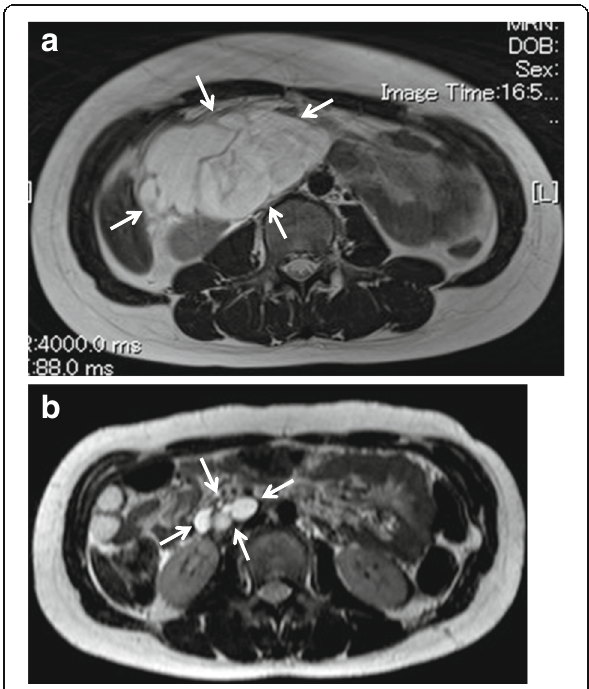
Fig. 2 At the first admission, magnetic resonance imaging (MRI) showed that a large multicystic mass ( arrow ) revealed hyperintense on T2 images and did not contain any fat tissue ( a ). Six months after